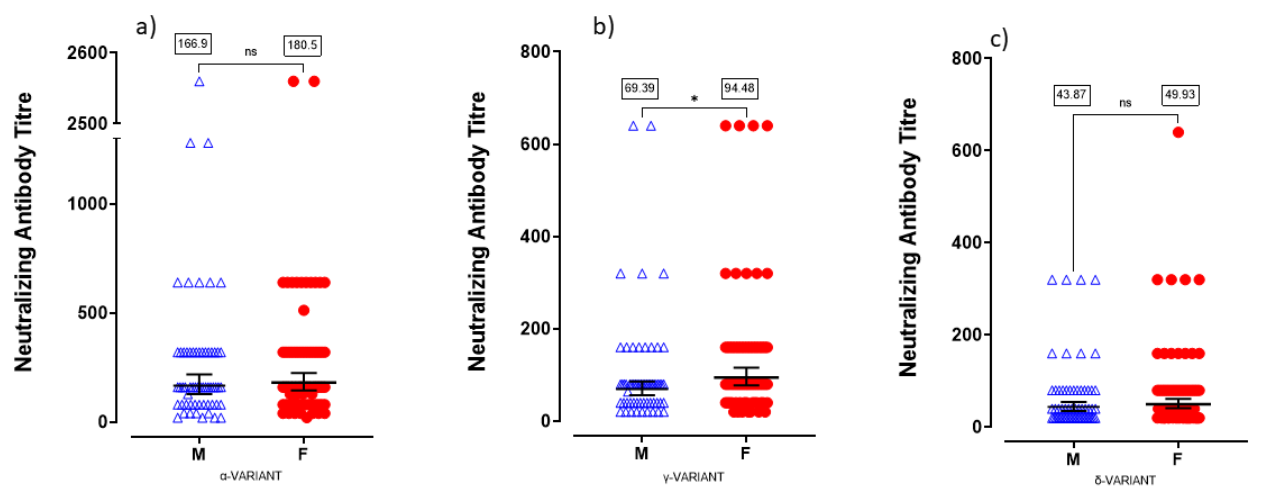
Figure 2. Gender effect on neutralizing antibody titre against variants of concern: ( a ) neutralizing antibody titre against Alpha variant in male and female subjects, ns = not significant; ( b ) neutralizing antibody titre against Gamma variant in male and female subjects, * p < 0.05; ( c ) neutralizing anti- body titre against Delta variant in male and female subjects, ns = not significant .